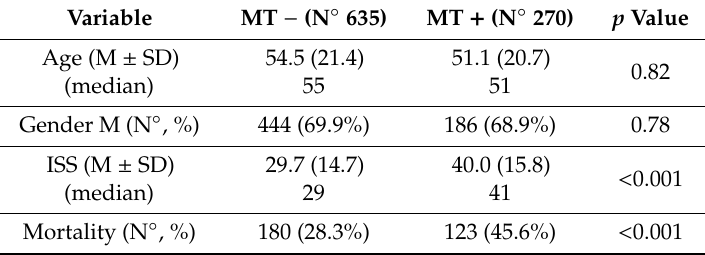
Demographic variables of 905 patients from TR-DGU with at least one episode of systolic